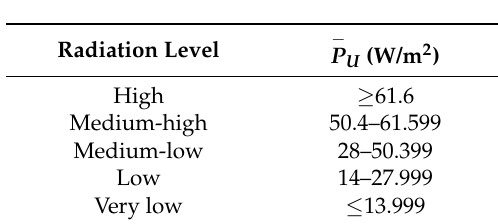
Table 1. Radiation